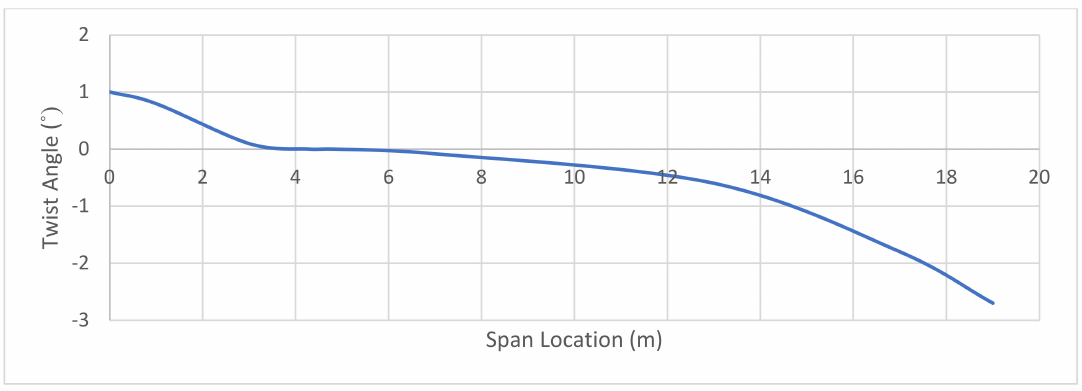
Figure 2. Spanwise twist distribution of the re-shaped wing model.